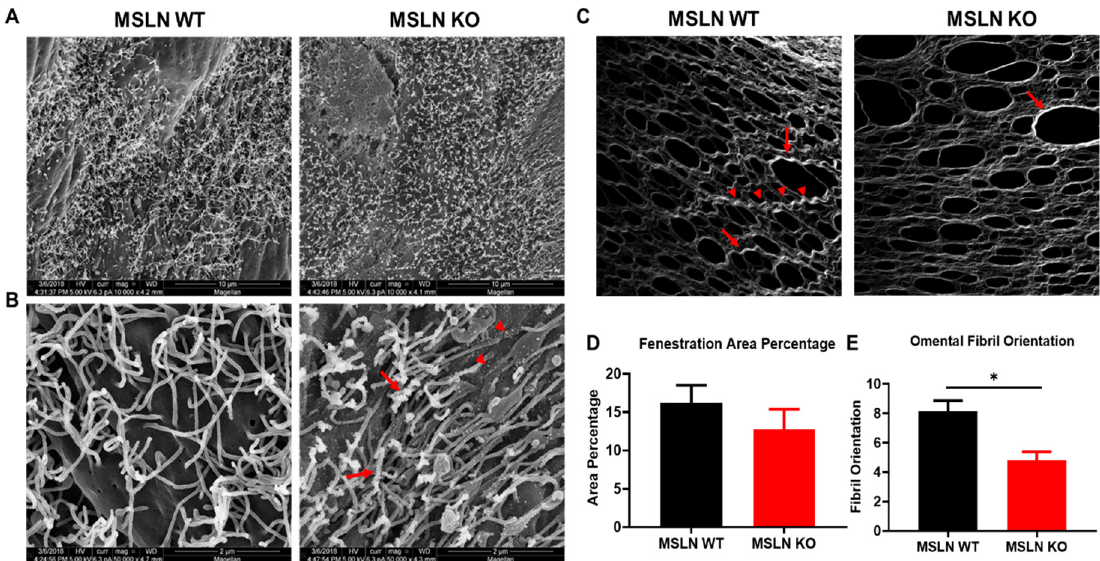
Figure 2. Ultrastructural analysis of MSLN WT and MSLN KO peritoneal tissues. Peritoneum of MSLN WT and MSLN KO mice were imaged using a scanning electron microscope. Images of mesothelial cells were taken at ( A ) 10,000× and ( B ) 50,000×. MSLN KO peritoneum displayed structural differences in microvilli including rough cell surface, underdeveloped microvilli nanoscale nodular structure (arrow heads), and excessive budding nodules (arrows) from microvilli compared to MSLN WT peritoneum. ( C ) Evaluation of omental collagen by second harmonic generation (SHG) microscopy. Representative images of omental collagen from MSLN WT and MSLN KO mice. Long (arrow heads) and thick (arrows) banding were more prominent in MSLN WT tissues. MSLN KO tissues have less thick banding (arrow). ( D ) Using ImageJ, fenestration area percentage and ( E ) fibril orientation was measured using SHG images. * p < 0.05; error bars represent standard error of mean.